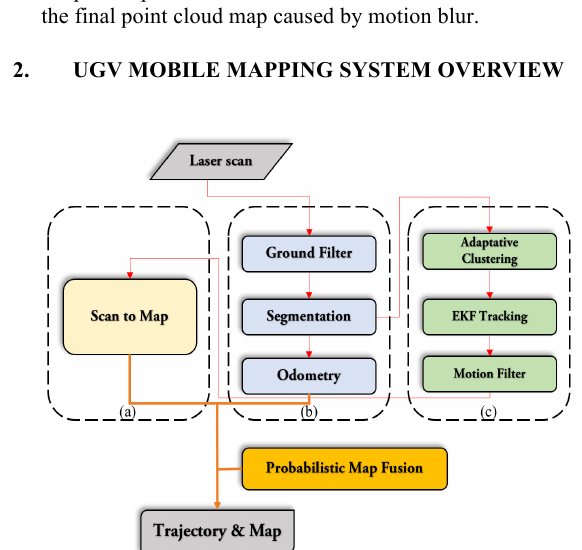
Figure 1. Simple flowchart of our system. (a) Laser mapping thread; (b) Laser odometry thread; (c) DATMO thread. (All threads run